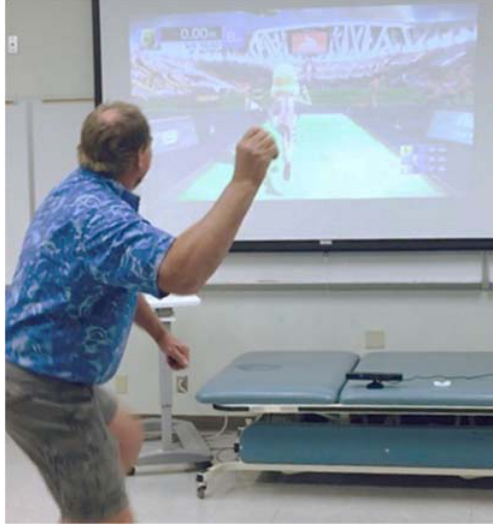
Figure 1. One subject is playing javelin throw in Kinect Sports by using Xbox